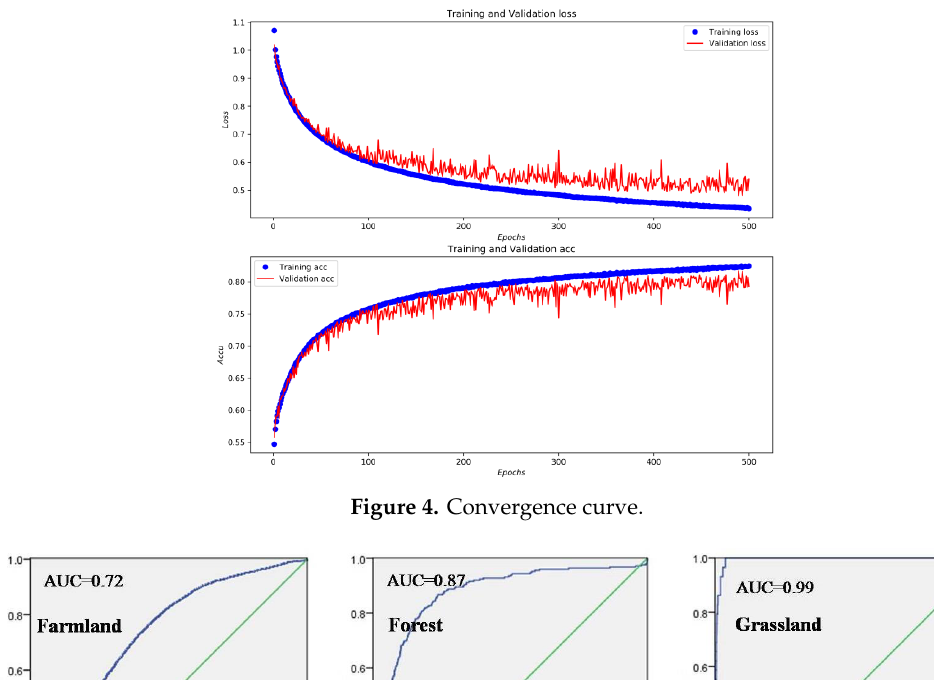
Figure 6. Ecological sensitivity in 2010. Figure 7. Restricted area of Puge County.